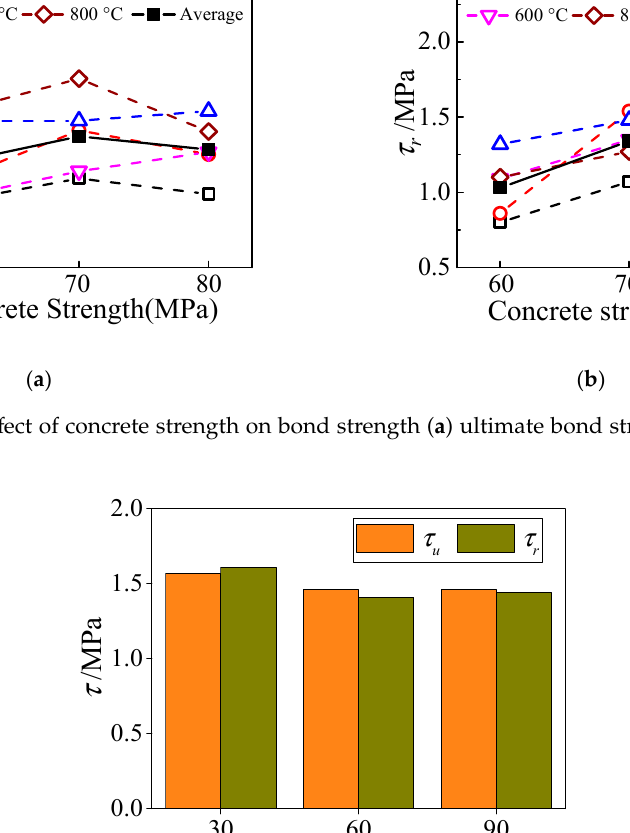
Figure 17. The e ff ect of constant temperature duration on bond Figure 17. The effect of constant temperature duration on bond behaviors.